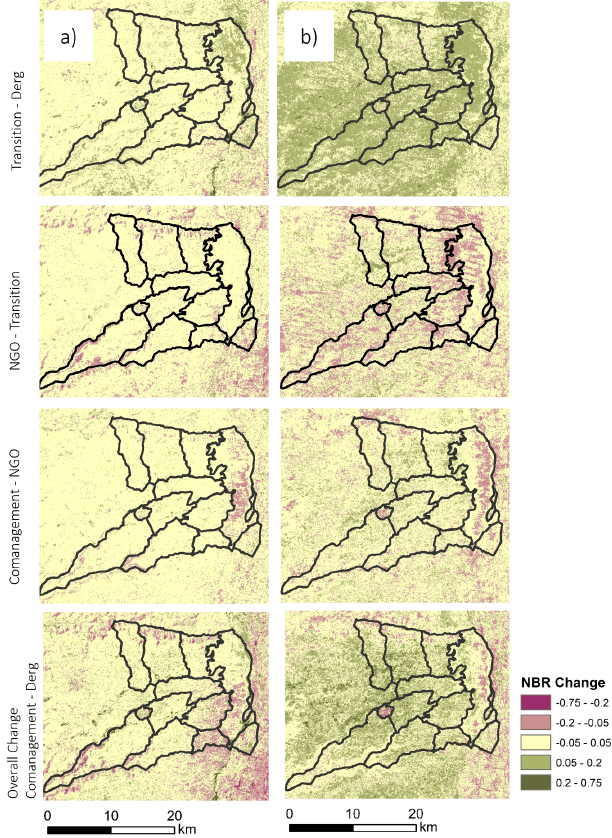
Fig. 5 . Normalized Burn Ratio change across four periods of political and management history. Column (a) shows dry season change, whereas column (b) shows wet season change. The first row shows change between the Transition period (1991 – 2003) and Derg period (1985 – 1991), the second row shows the NGO period (2003 – 2012) minus the Transition period, and the third row the CoManagement period (2012 – 2017) minus the NGO period. The fourth row shows the overall change across the entire Landsat record (CoManagement minus Derg). Note that wet season results in the first and second rows are being influenced by the scan-line